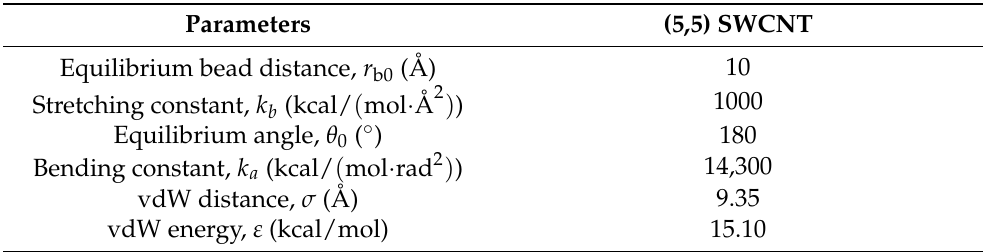
Table 1. Potential parameters for the coarse-grained model of (5,5)